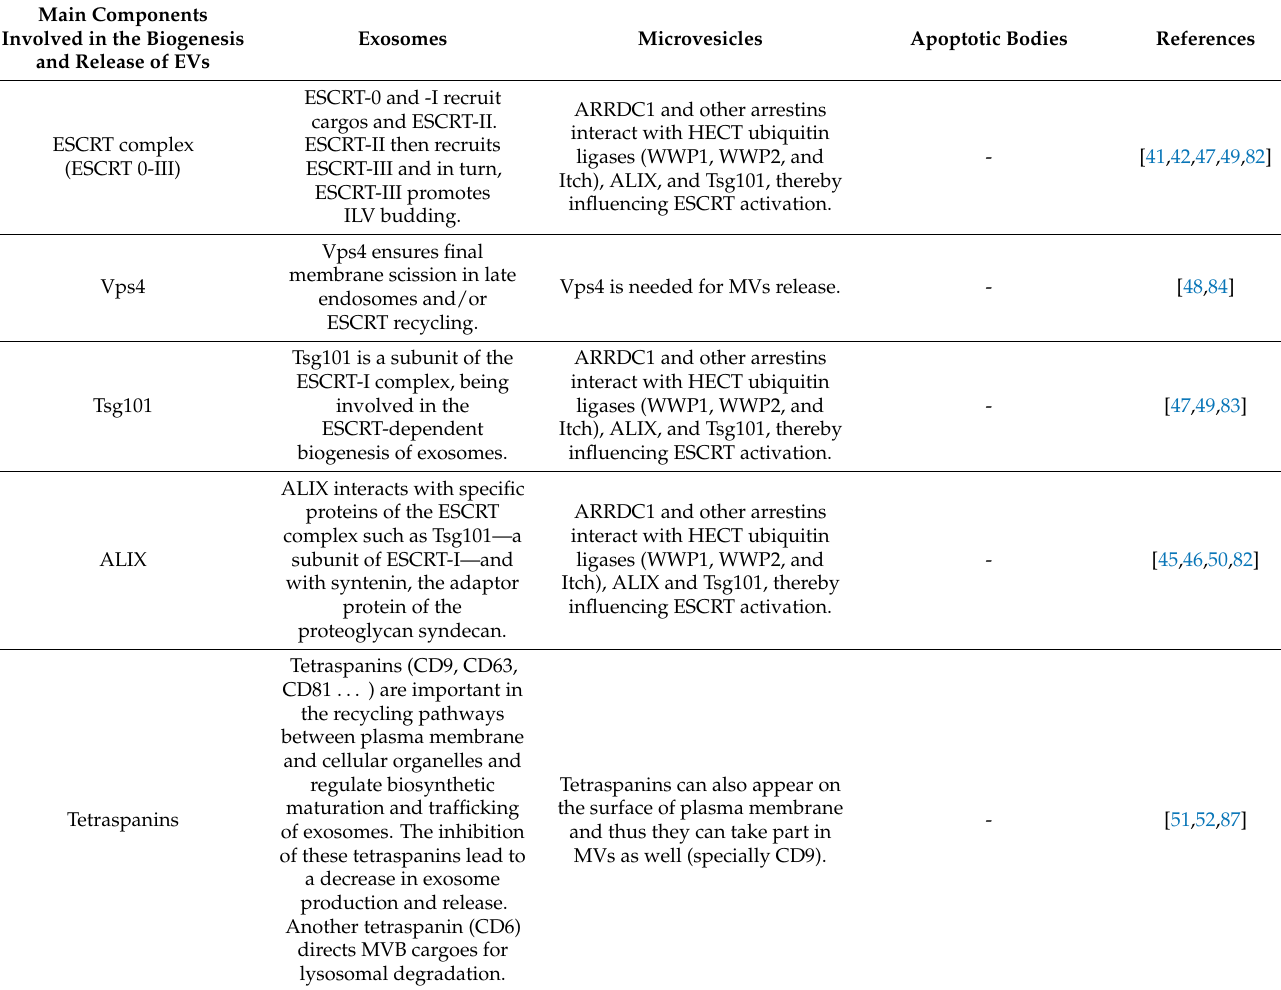
Table 1. Summary of the main proteins and molecules implicated in the biosynthesis of